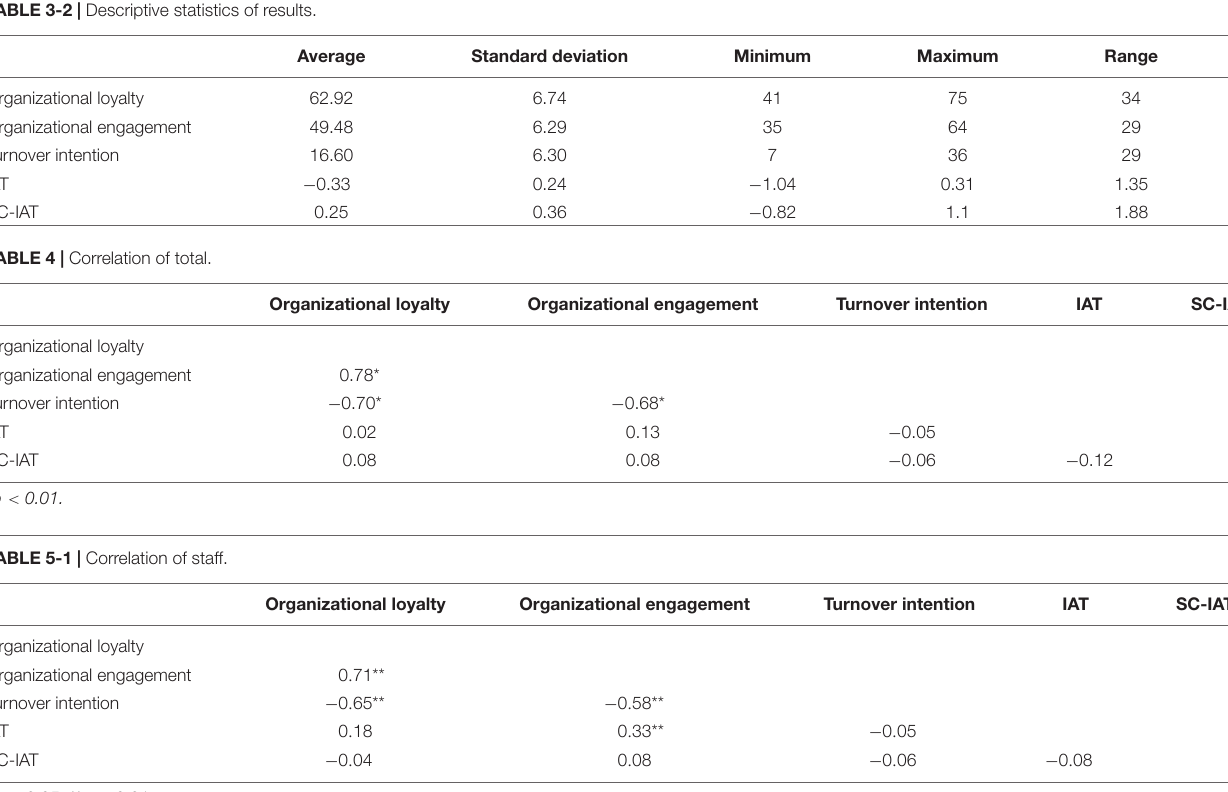
TABLE 3-2 | Descriptive statistics of results.